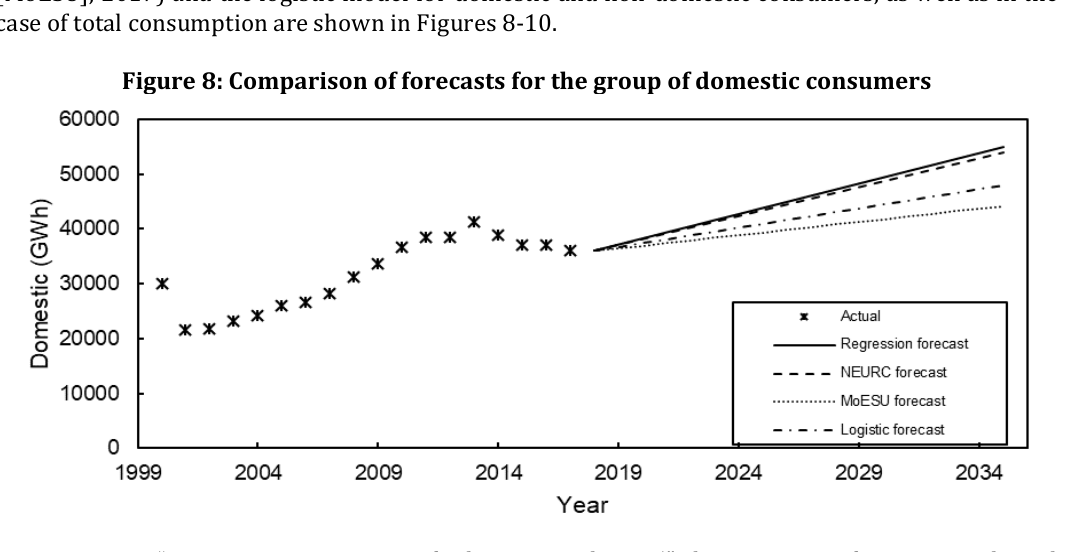
Source: “New Energy strategy of Ukraine until 2035”, by Ministry of Energy and Coal Industry of Ukraine. (2017). Available at “Perspectives of ‹ 54 ›